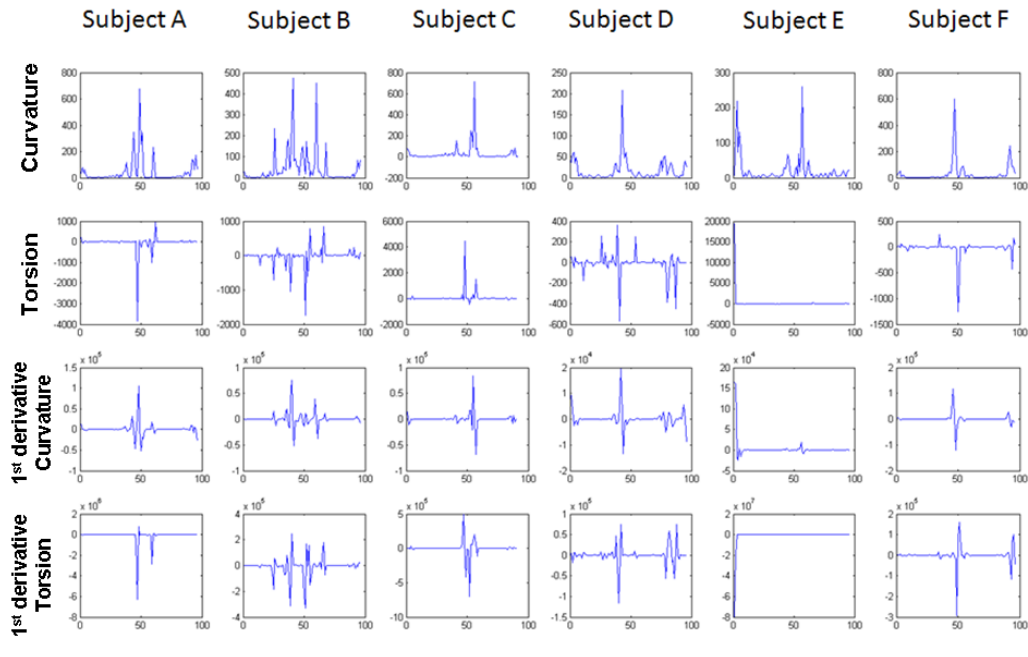
FIGURE 10. Trajectories’ transformation to view-invariant